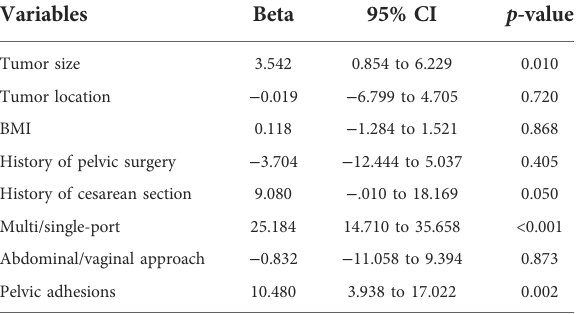
TABLE 4 Association between operative bleeding and myomectomy types.